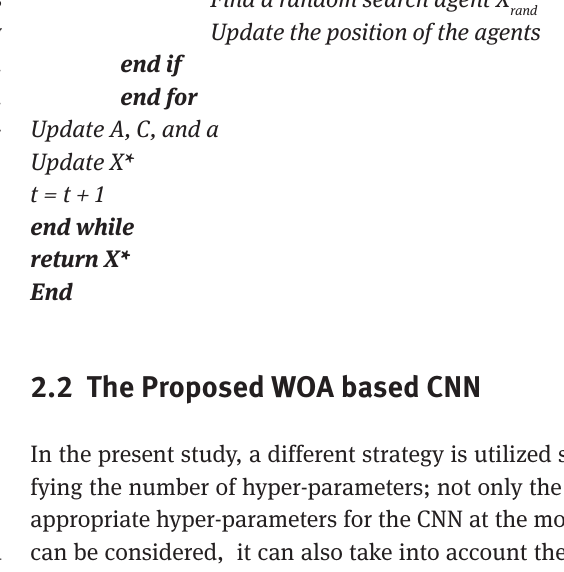
figure 2, it is clear that the humpback whale first creates bubbles around the prey. This process is performed by spiral motion of the whale. Afterward, it attacks the prey.